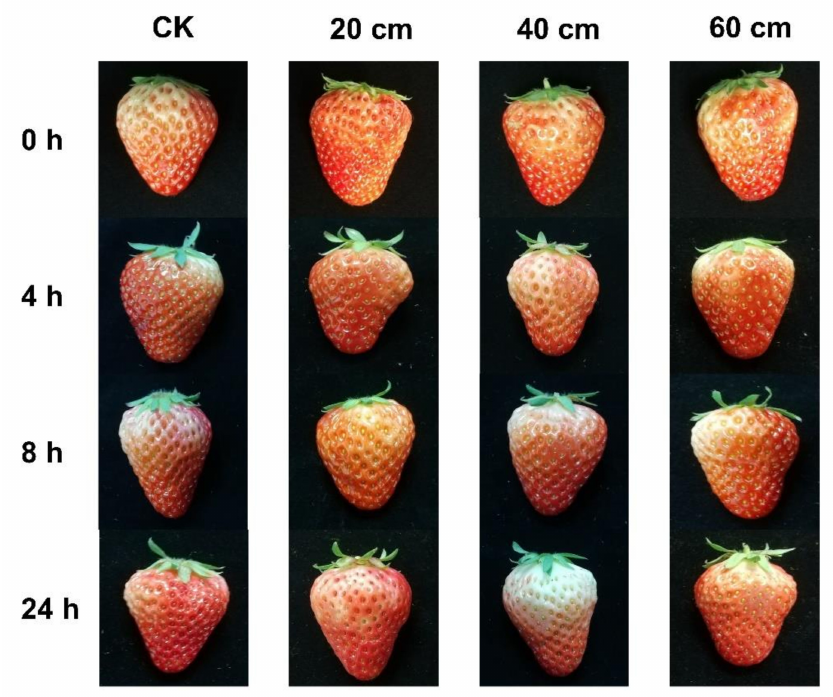
Figure 1. Strawberries with different damage extents and post-impact storage